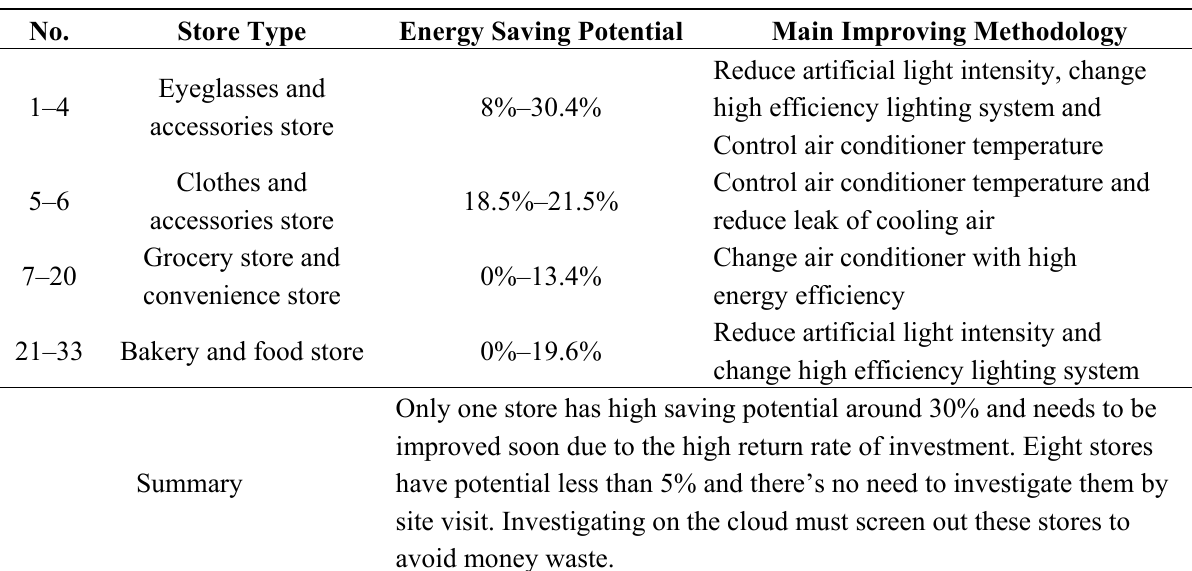
Table 3. In order to verify the effectiveness of investigating energy saving potential on cloud and check, 33 stores are investigated by site visit. Energy saving potential is listed